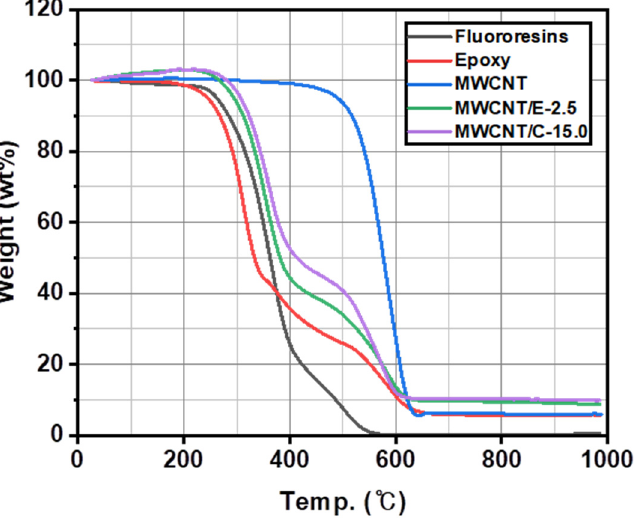
Figure 1. Thermal decomposition according to the composition of the solid lubricants.